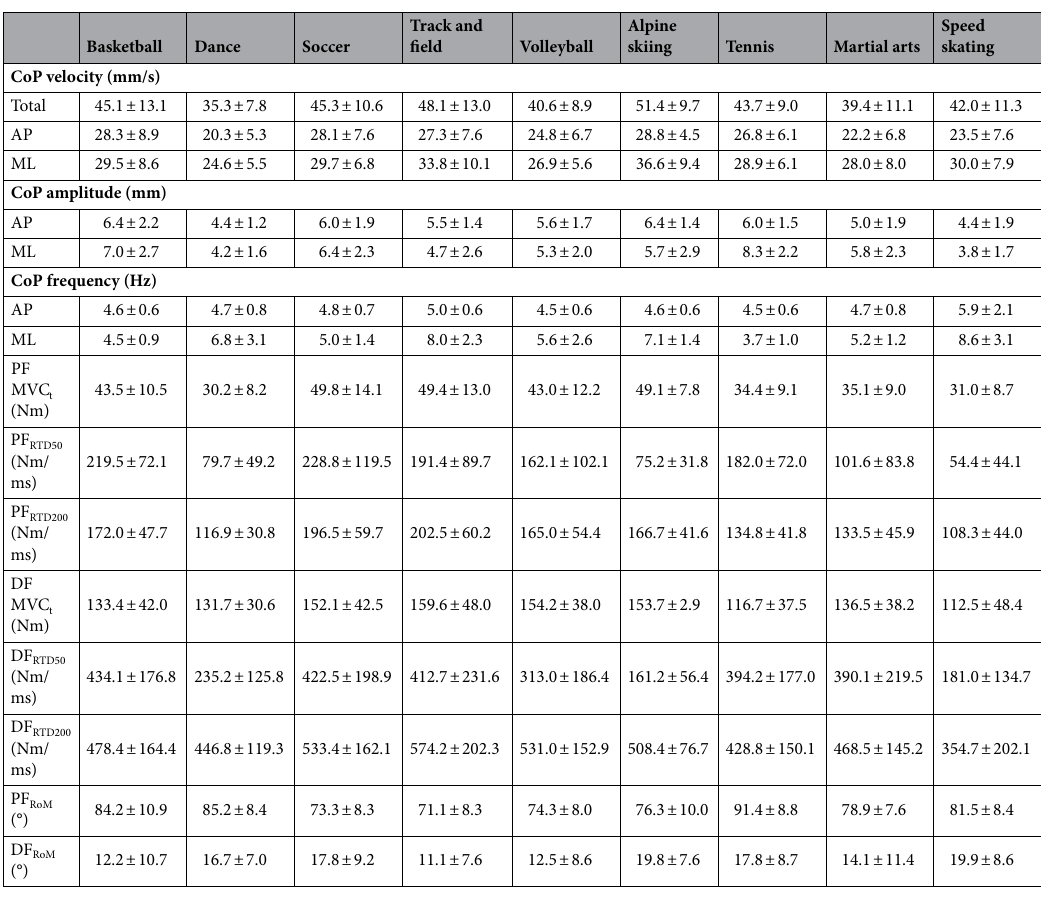
Table 2. Descriptive data for ankle PF and DF muscle strength, RoM and CoP variables. AP anterior– posterior, ML medial–lateral, PF MVCt maximal voluntary contraction torque for plantar flexion, PF RTD50